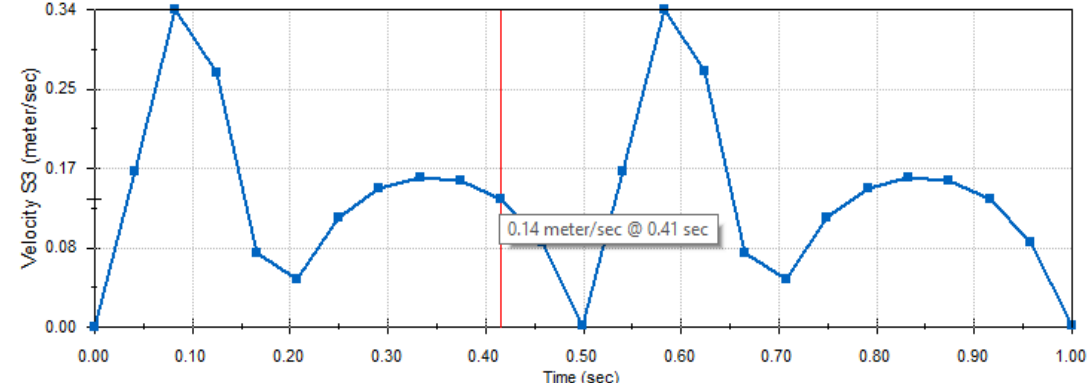
B crank center of mass (S 2